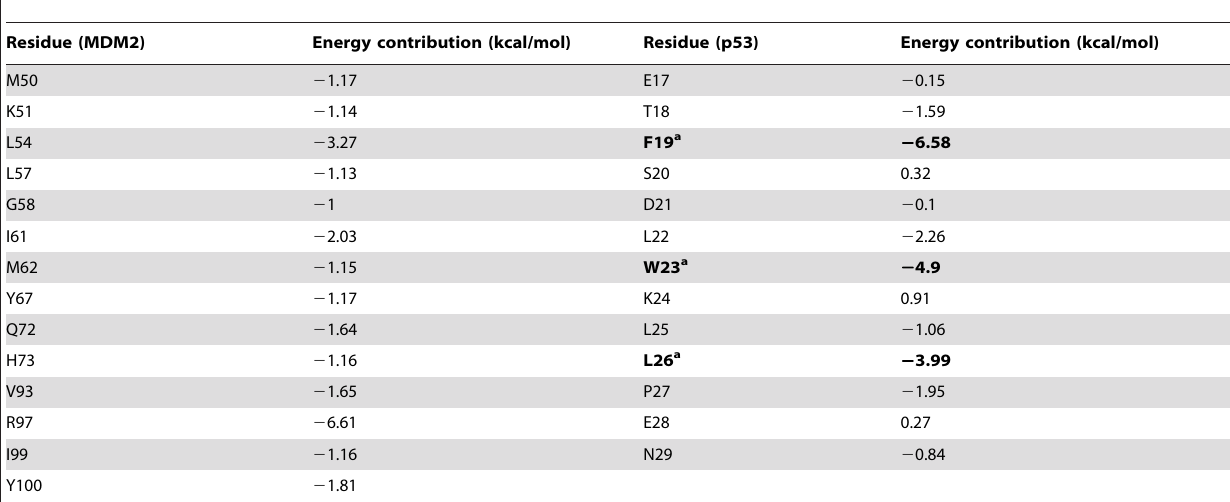
Table 4. Residual decomposition analyses to recognize the important contributors of MDM2 and p53 peptide.